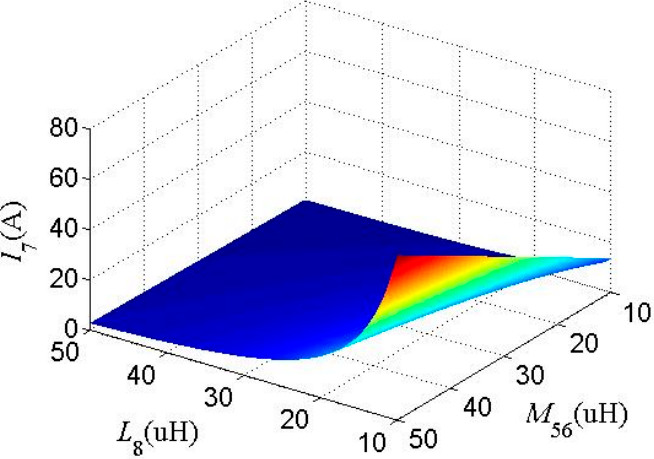
Figure 6. Output current of the LCC-LCC topology.